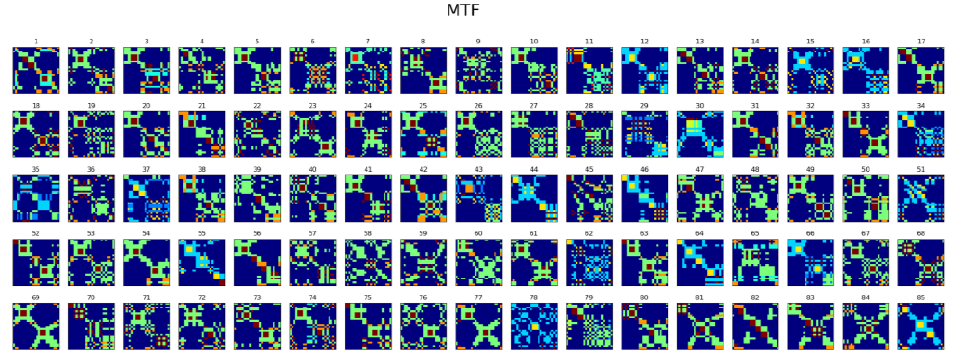
Figure 13. Proposed detecting anomaly method using time series images (MTF).